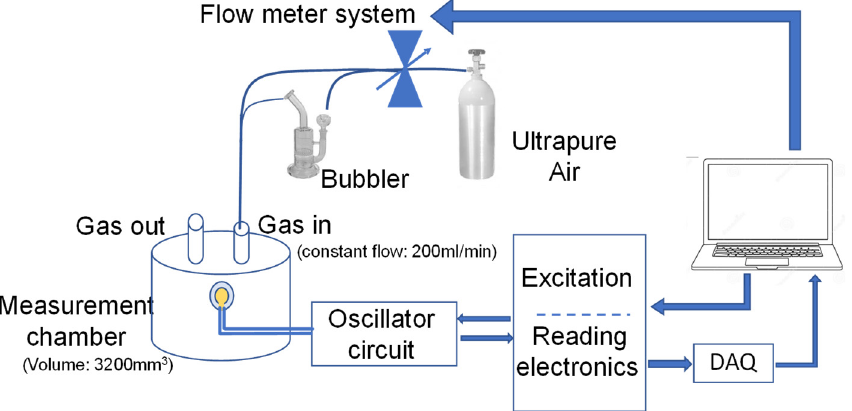
Figure 1. Measurement system setup.